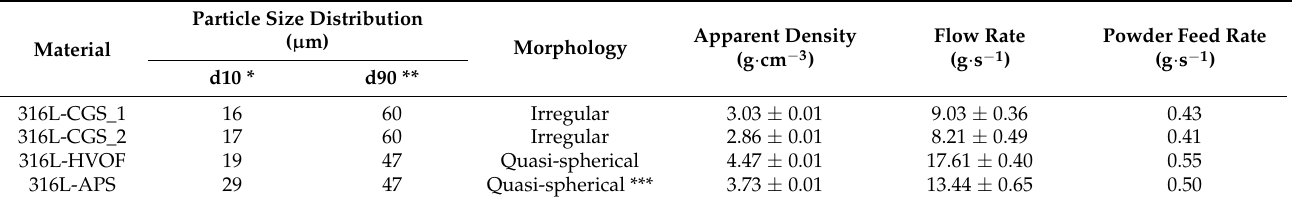
Table 3. Particle distribution, apparent density, and flow rate of the 316L feedstock